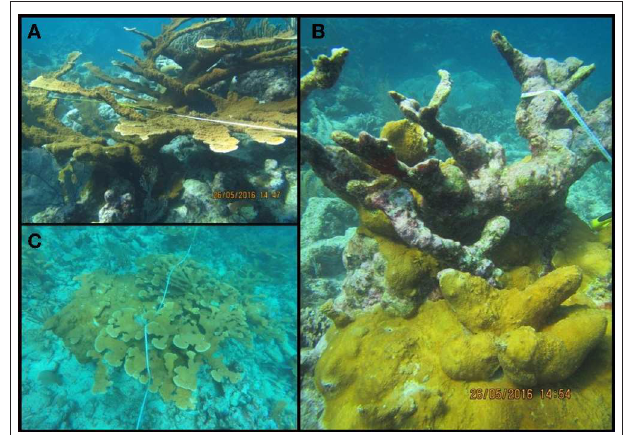
FIGURE 1 | Examples of elkhorn coral ( Acropora palmata) growth forms. (A) Typical branching colony growth form. (B) An example of re-sheeting growth over a relict elkhorn colony. (C) An elkhorn thicket, and in this case contains both growth forms, with re-sheeting regrowth on the left side of the thicket and more typical branching colonies on the right and upper side of the